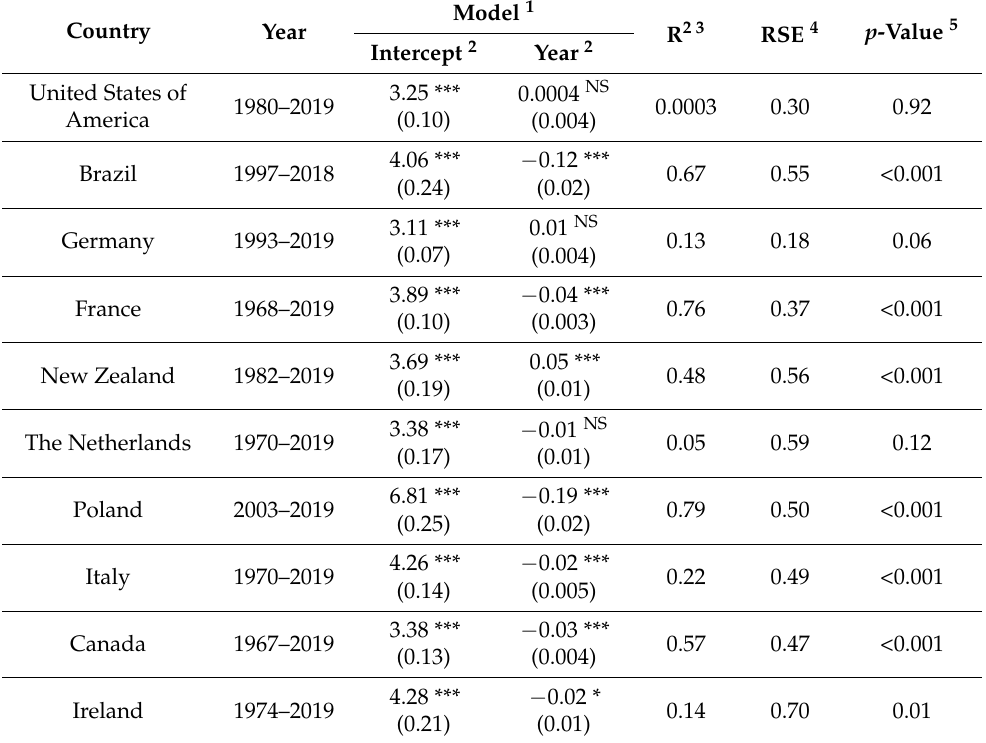
Table 3. The linear trend of the length of productive life (year) in each country. The list of countries is limited to the world’s top high milk-producing countries for which we were able to provide sufficient and reliable data on the length of productive